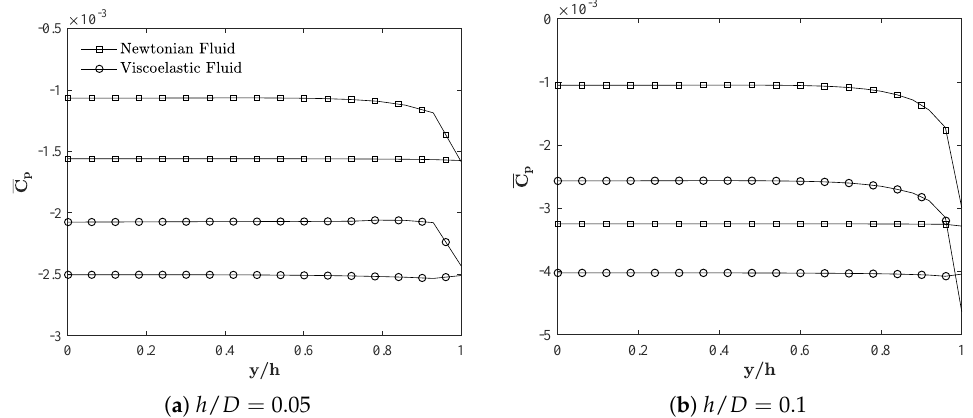
Figure 9. Mean pressure coefficient profile ( C p ) along the roughness element upstream and down- stream